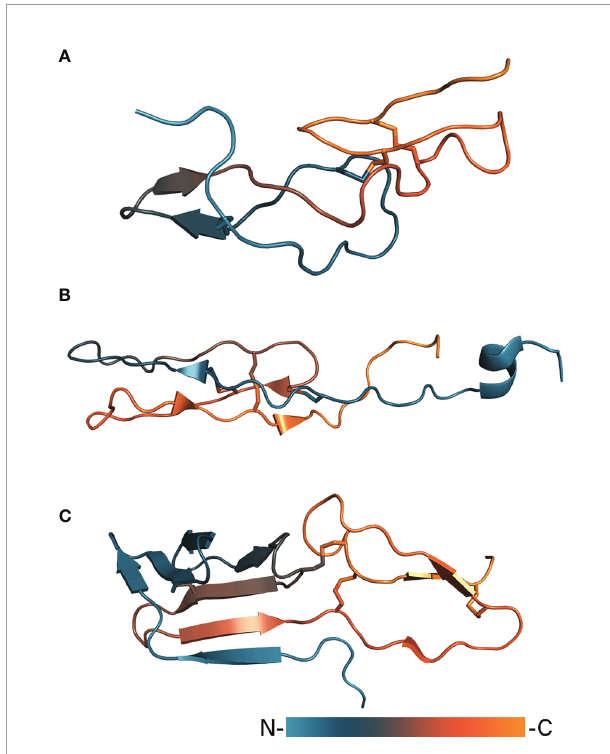
FIGURE 4 | Tick complement inhibitors BSAP1 ( A , PDB: 7NE8), RaCI2 ( B , PDB: 5IEC), and CirpT ( C , PDB: 6RPT). Proteins are colored according to a gradient from N - to C